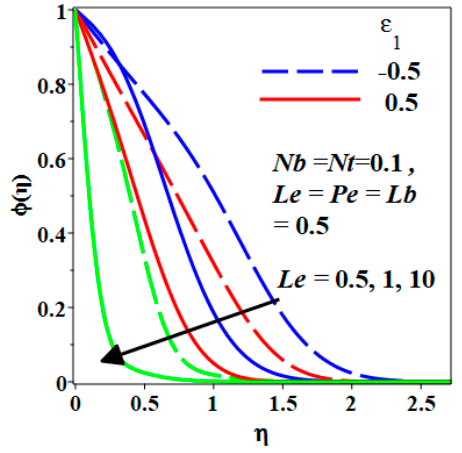
ε on ( ) φη . Figure 4. Variation of Le and ε φ ( η ) 1 on 1